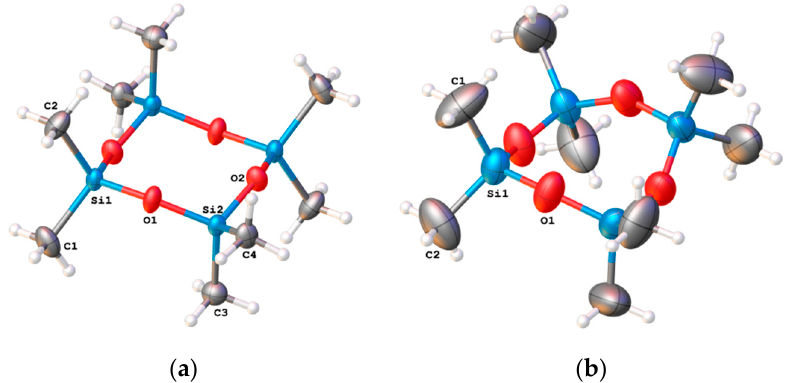
Figure 1. Conformations in low- ( a ) and high-temperature ( b ) phases. Ellipsoids are set at 50% probability. The highest value of the equivalent atom displacement parameter (U eq ) for carbon atoms at 270 K is 0.13 Å 2 . At the same time, the positions of carbon atoms could not be separated without applying strong restraints (EADP and DFIX) due to the absence of reflections at high 2 θ values (>50 ◦ ). The U eq values of oxygen and silicon atoms do not exceed 0.1 Å 2 . The shapes of atomic displacement parameter (ADP) ellipsoids are far from spherical; they are considerably stretched in a perpendicular (Si and O atoms) or tangential (C atoms) direction to the mean plane of the siloxane ring. Such behavior of ADP ellipsoids is indicative of the intensive molecular vibrations related to the folding of the siloxane cycle. As a consequence of thermal motion, Si1-O1 and Si1-O1[5/4 − y,1/4 + x, 5/4 − z] bonds (1.611(2) and 1.623(2) Å at 240 K) are somewhat shorter than those published in 1955 by Steinfink et al. for the low-temperature phase (1.64–1.66 Å). The length of Si1-C1 and Si1-C2 bonds (1.835(3) and 1.822(4) Å) also turned out to be shorter than those published earlier [8] by 0.07–0.12